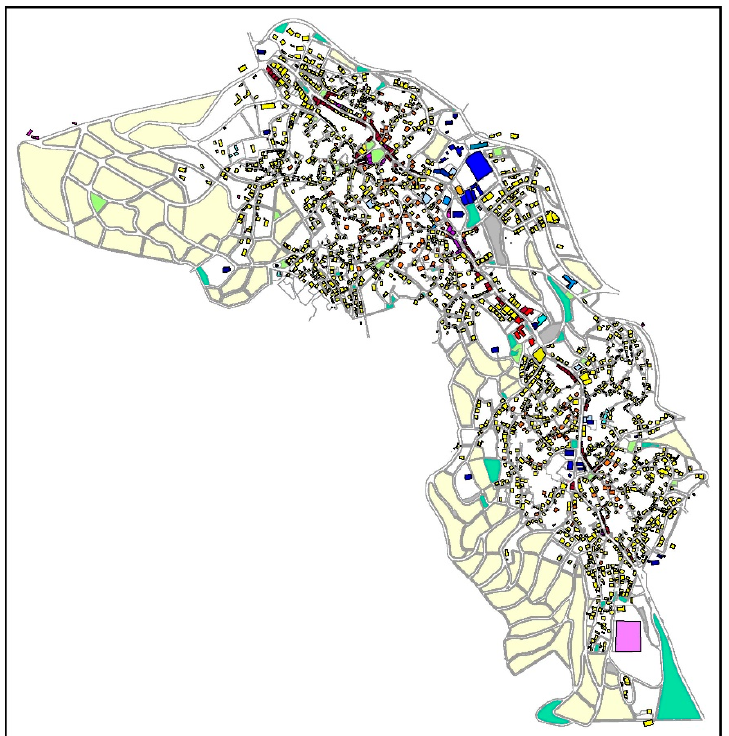
Figure 12. Land use map.